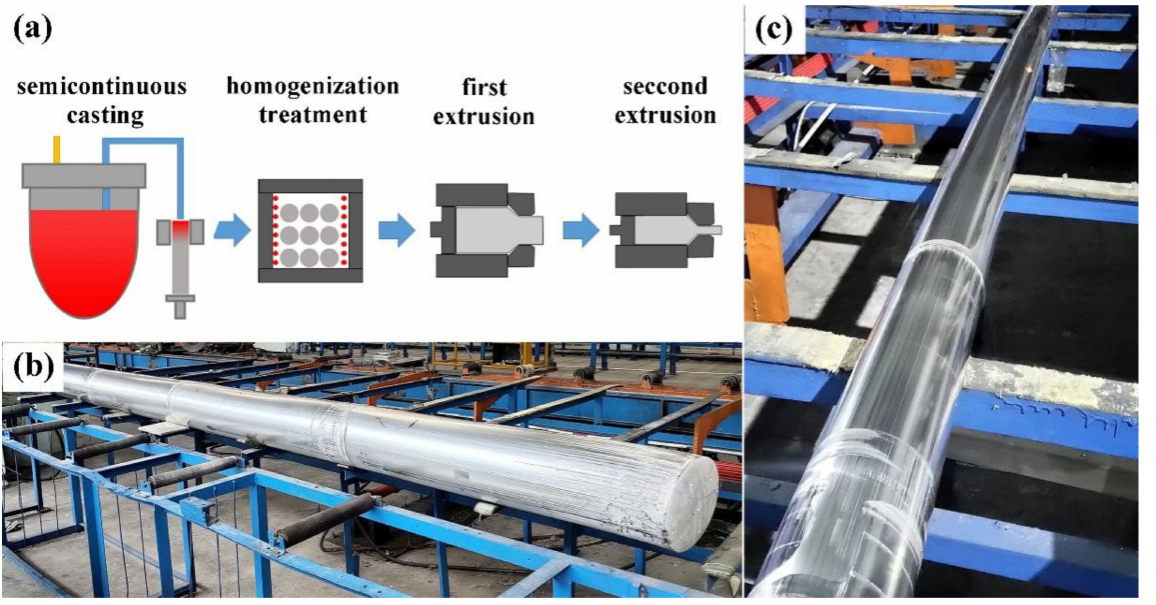
Figure 1. ( a ) Schematic diagram of the preparation process of the large-scale dissoluble magnesium alloys. Photos of the extruded alloys: ( b ) AZN800-A, ( c )